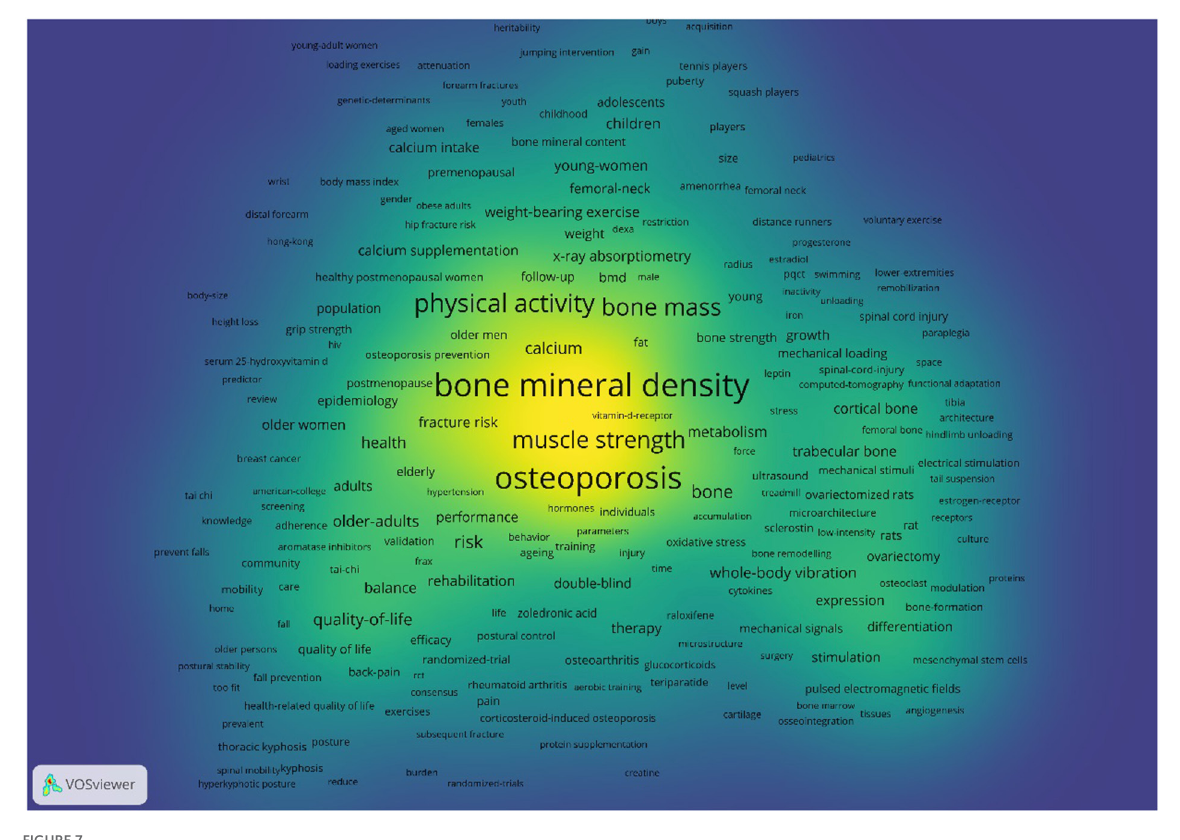
FIGURE7 Co-occurrence analysis of keywords by density